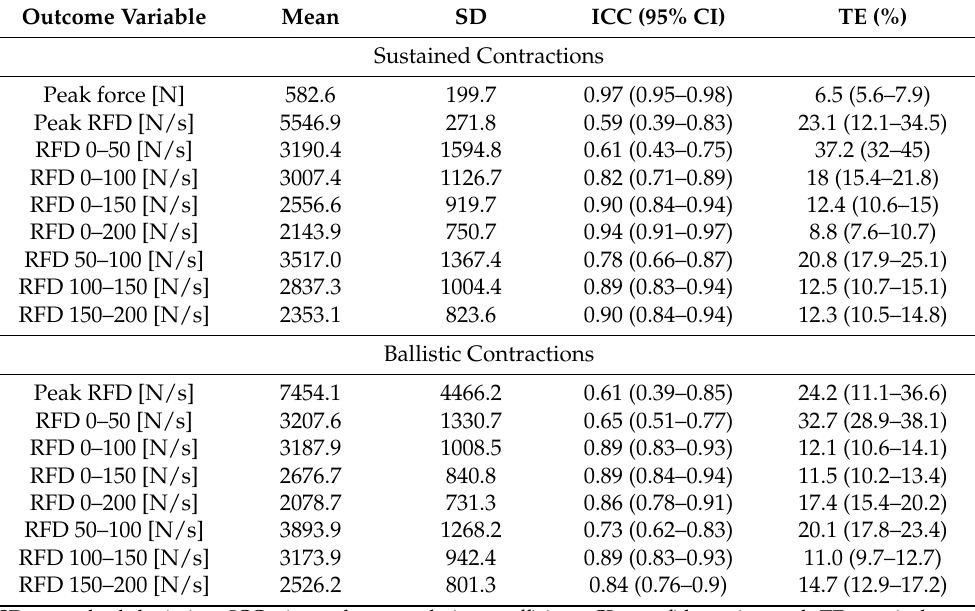
Table 2. Descriptive statistics and reliability analysis for knee extension